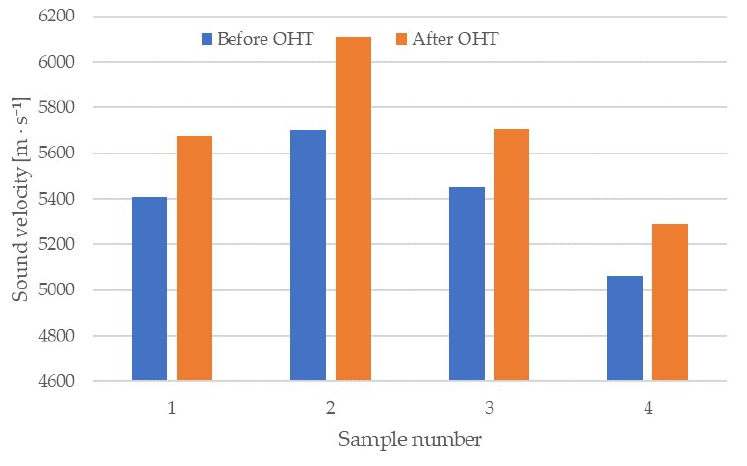
Figure 3. Speed-of-sound propagation in the longitudinal direction of the analyzed wedges, before and after modification.